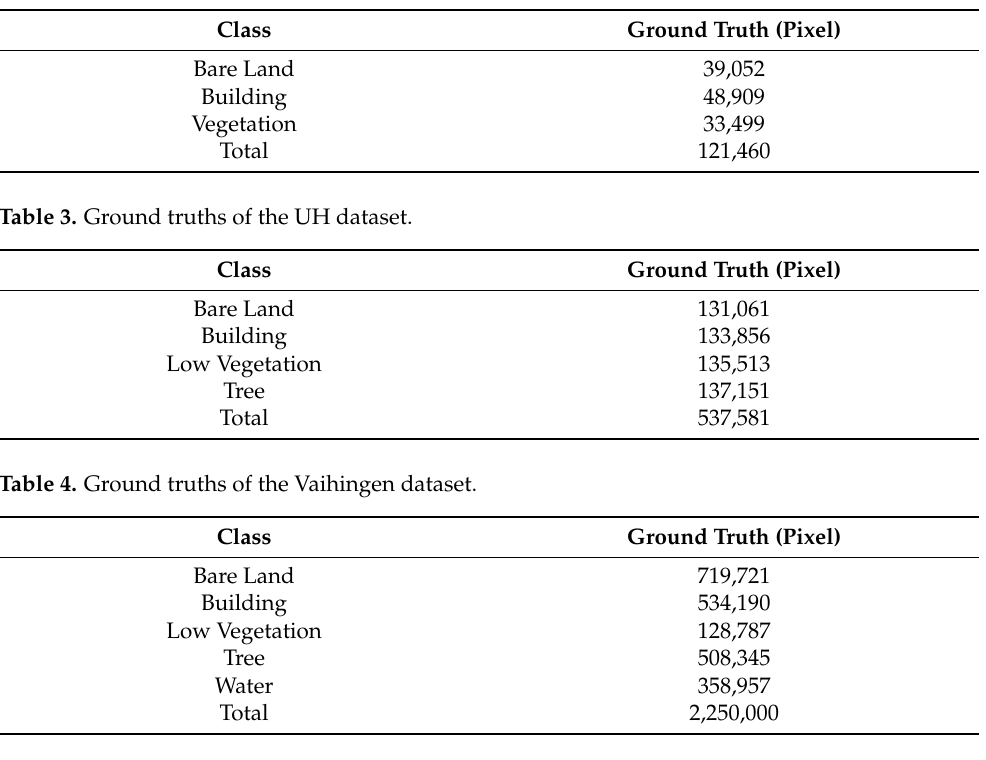
Table 2. Ground truths of the Tunis dataset.